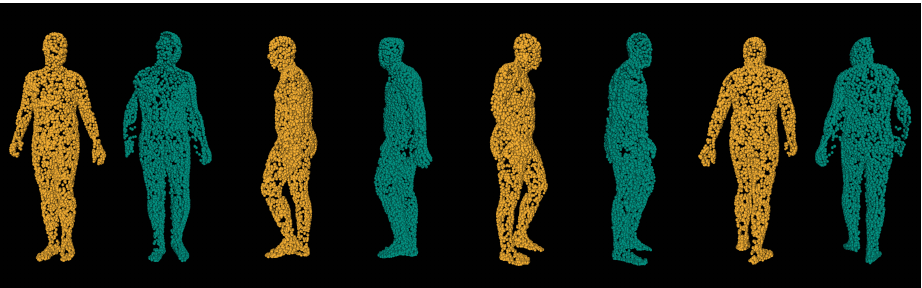
Figure 8. Comparison of ground truth (left/orange) and prediction (right/teal) from differ- ent